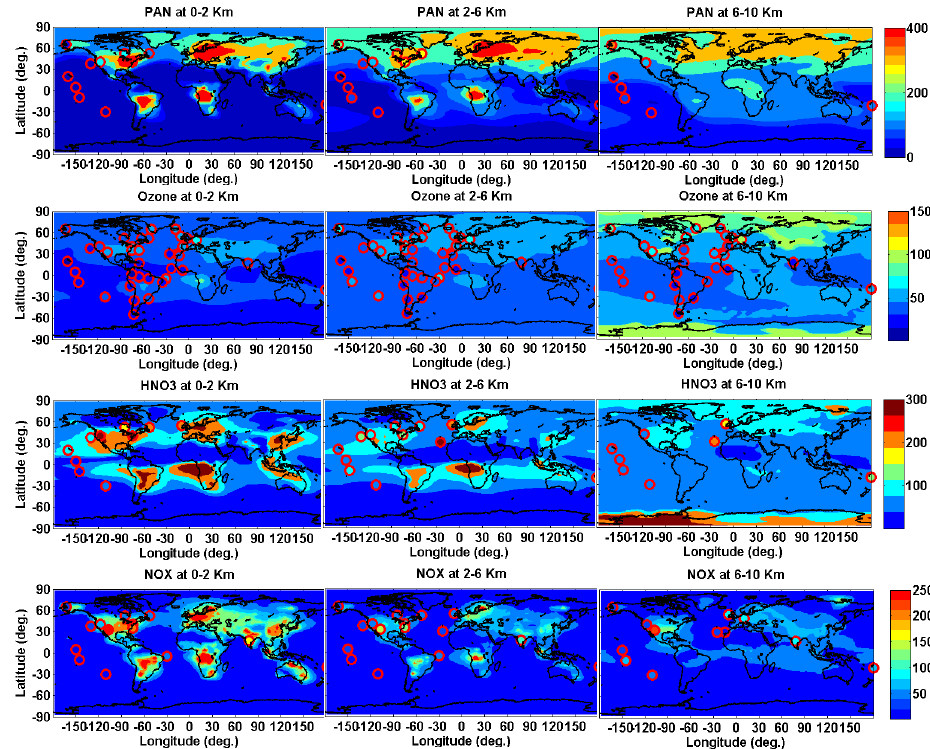
Figure 1. Global mean distribution of PAN (ppt), ozone (ppb), HNO 3 (ppt) and NO x (ppt) averaged for the monsoon season and altitude ranges. Model results from reference simulation (background solid contours) are compared with aircraft observations from Table 1 for all the years (filled circles). Aircraft observations are averaged vertically and horizontally over the coherent regions.